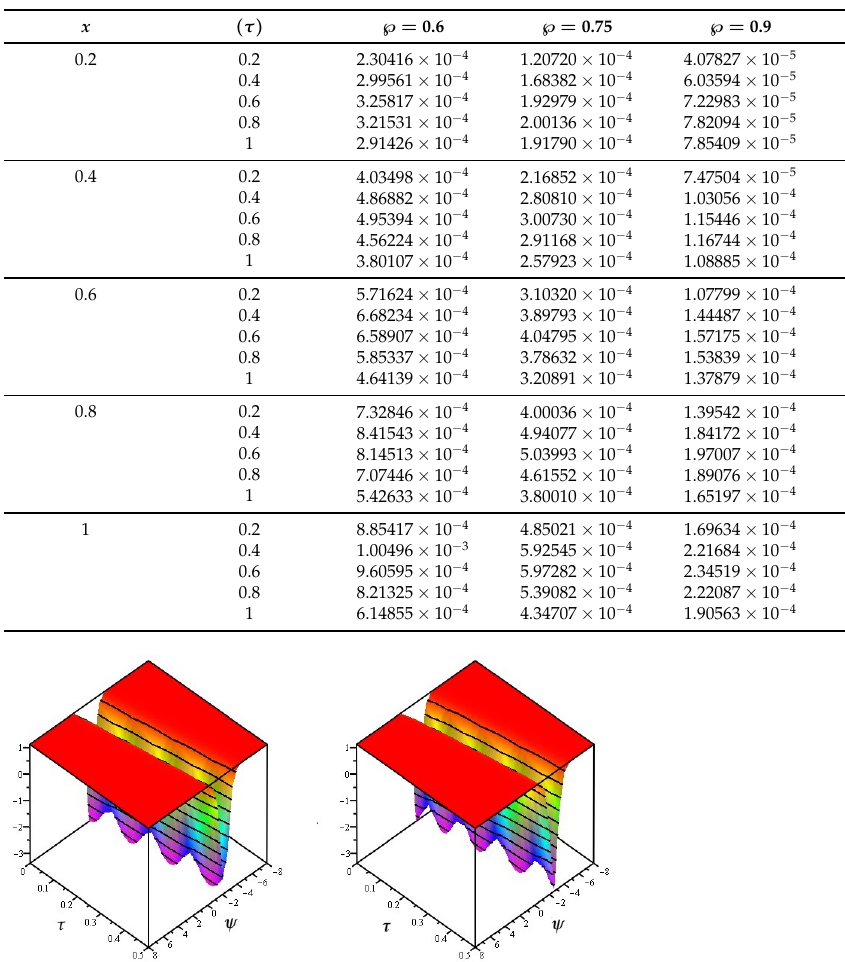
Figure 1. Exact and analytical solution of ν ( ψ , τ ) at (cid:118) = 1 and